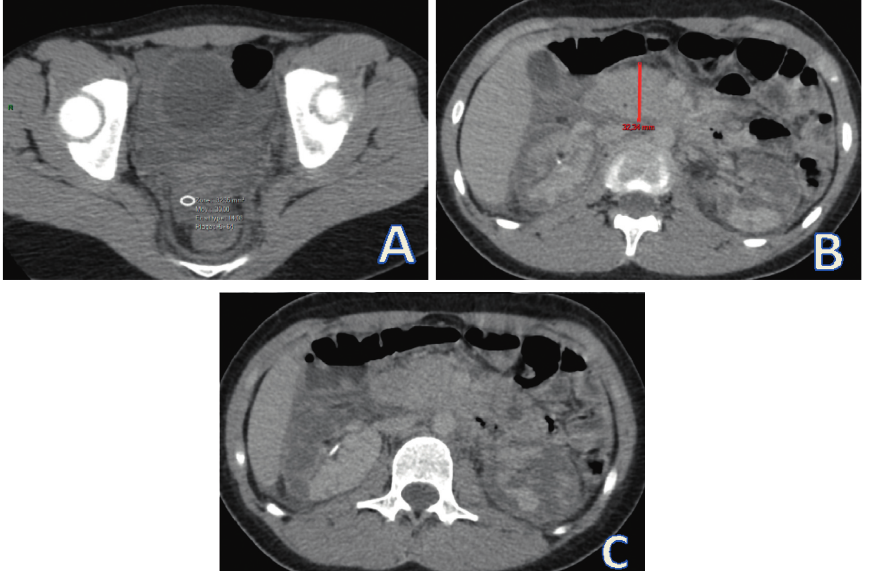
Figure 1: Abdomino-pelvic CTscan performed 12 hours after trauma, axial view. (a) Liquid of similar density as blood: haemoperitoneum. (b) Increase of pancreatic head size: pancreatitis. (c) Heterogeneous renal parenchyma with decreased enhancement during venous phase indicating ischemic lesions and